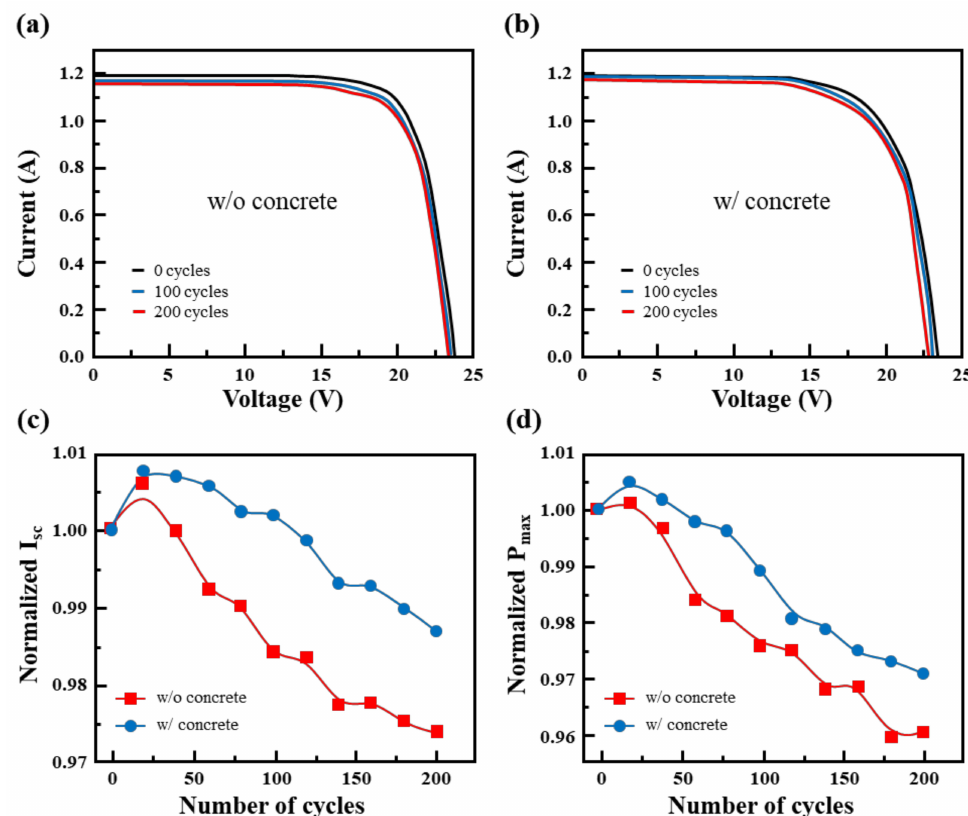
Figure 13. I-V characteristics before and after 100 and 200 thermal cycles for a PV module ( a ) without and ( b ) with concrete. The difference of ( c ) I sc and ( d ) P max values before and after 100 and 200 thermal cycles for a PV module without and with